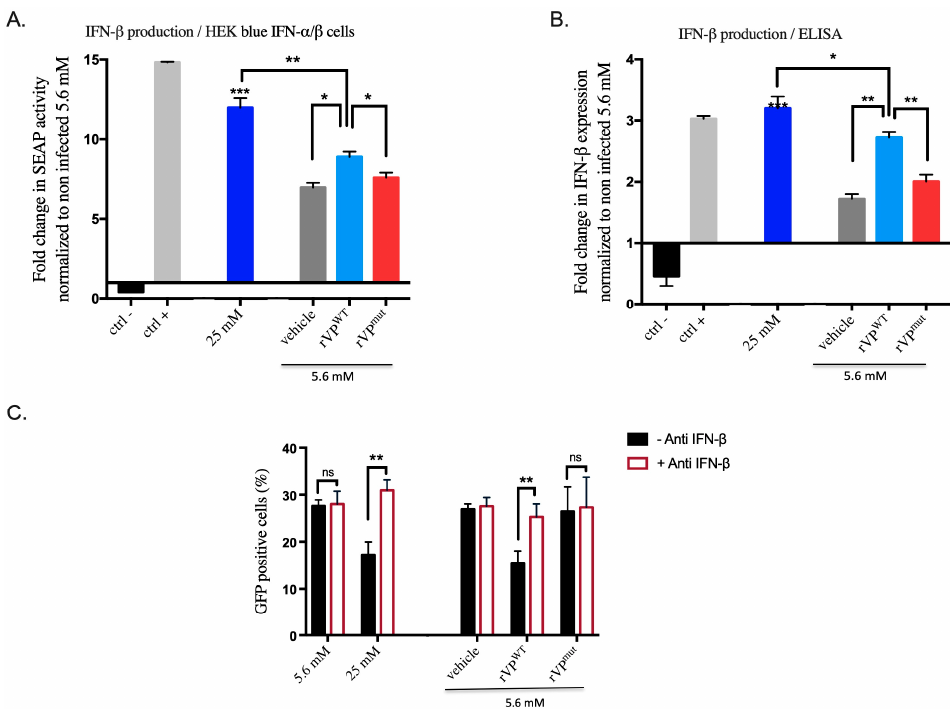
Figure 5. Viperin overexpression mediated IFN- β secretion in HK-2 HGC cells exerts an anti-ZIKV activity. ( A ) HK-2 NGC and HK-2 HGC cells media were transfected with rVP wt or rVP mut , or non- transfected as control. To evaluate type I interferons by using SEAP activity, supernatants were transferred onto HEK-blue IFN- α / β cells for a 24 h period with DMEM (ctrl − ) and IFN- β (ctrl+) as negative and positive controls, respectively. ( B ) Quantification of IFN- β in the supernatant of transfected or HK-2 NGC and HK-2 HGC cells was performed by the ELISA assay. In ( A , B ), results were represented as means ± SD. ( C ) Supernatant of transfected HK-2 cells were transferred on naive HK-2 NGC cells in the presence or not of anti-IFN- β for 2 h followed by ZIKV GFP infection for a 24 h period. Cells were subjected to flow cytometry analysis. Data are representative of at least three independent experiments. Results are shown as means ± SD. One-way ANOVA and two- way ANOVA show that differences either non-significant (ns) or statistically significant (* p < 0.05, ** p < 0.01 and *** p <